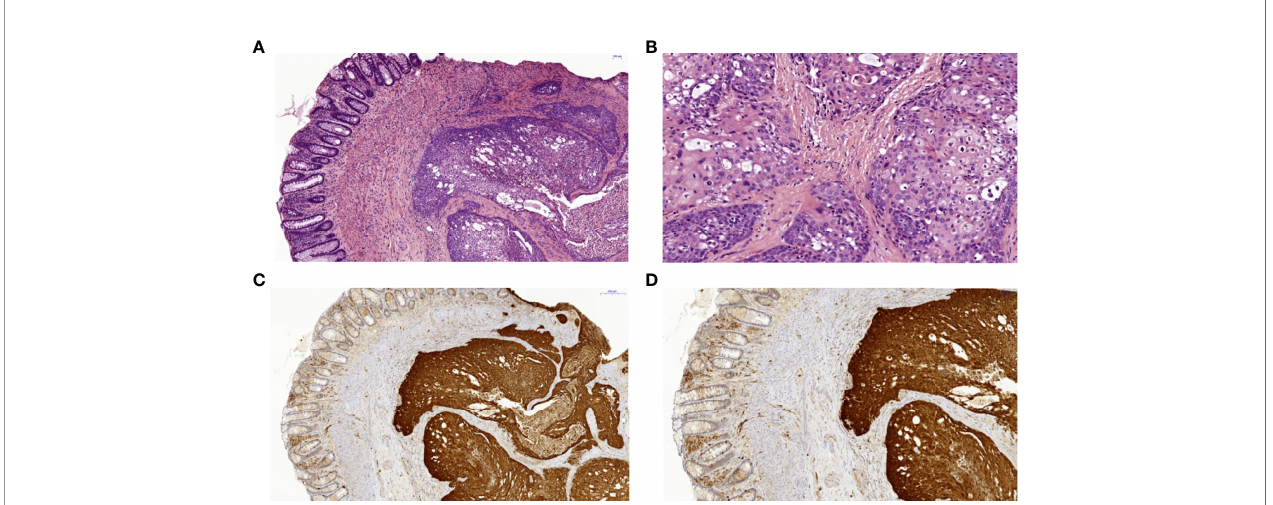
FIGURE 3 | Histopathology and immunohistochemistry of a squamous cell carcinoma of the anal canal in patient II.2. (A) Colorectal biopsy in H&E staining: left side colorectal mucosa, right side squamous cell carcinoma. (B) Anal squamous cell carcinoma in H&E staining with higher magni fi cation with cellular atypia and dyskeratoses. (C) Anal squamous cell carcinoma showing positive p16 immunohistochemical staining of the tumor cells as a surrogate marker for HPV-infection in 7x magni fi cation and (D) in 10.6x magni fi cation. HPV, human papilloma